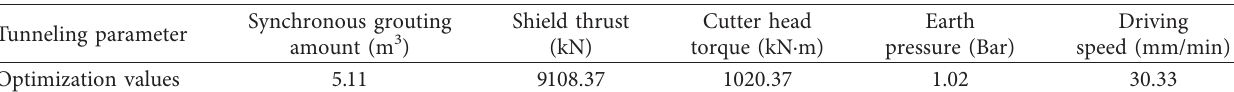
Figure 5: The interface of the parameter optimization based on EAIW-IPSO. Table 5: Optimization results based on SVM and